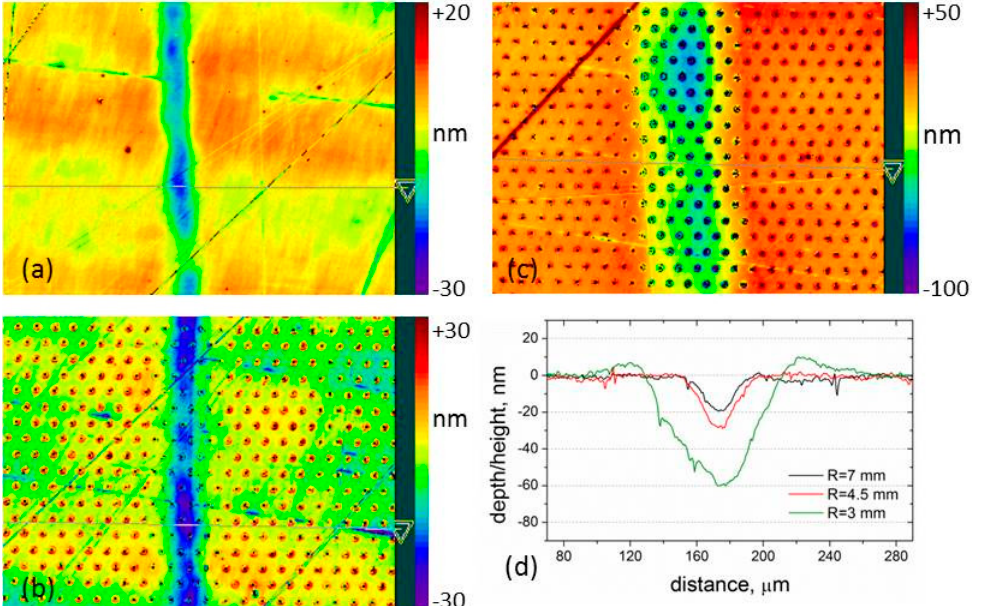
Figure 7. WLI images of the wear tracks formed on ( a ) the original film at R = 7 mm and ( b ) laser- textured surface at R = 4.5 mm after lubricated sliding at T = 23 °C, and ( c ) after all the successive lubricated sliding tests of the laser-textured film at R = 3 mm and different temperatures; ( d ) surface profiles across the tracks measured along the marked lines in the WLI images.